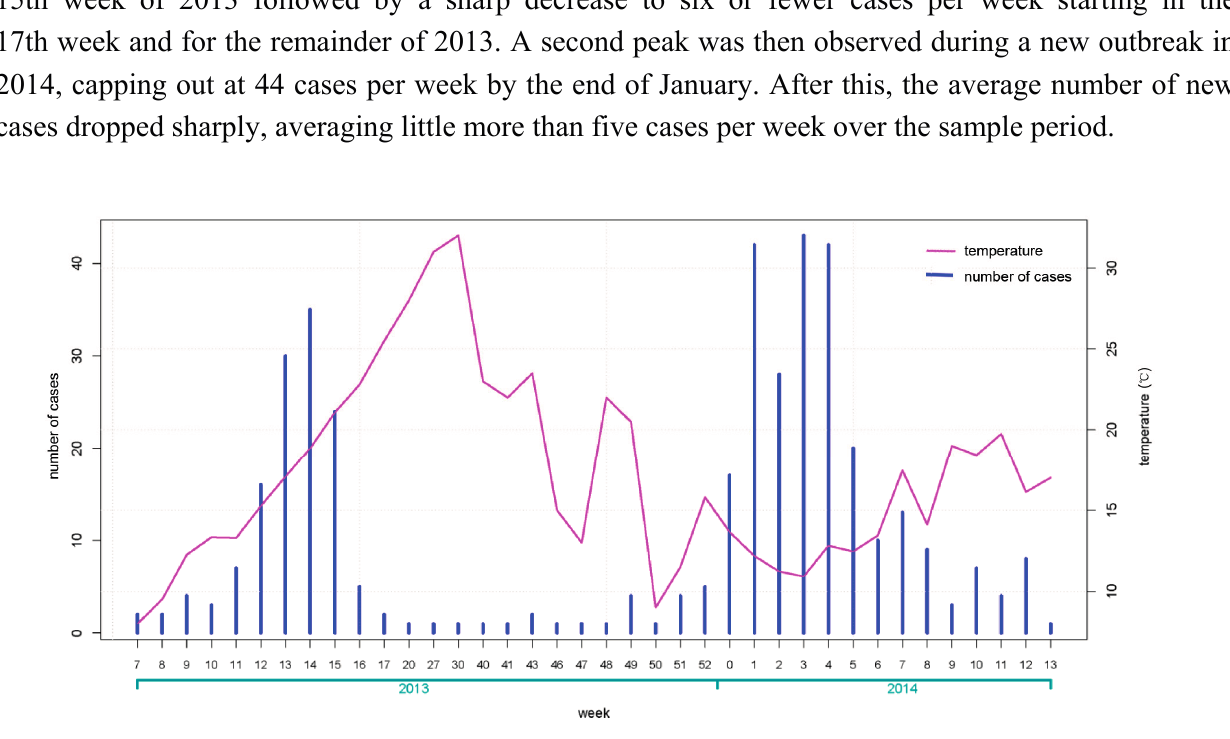
Figure 1. Weekly case number of human infection with avian influenza A (H7N9) virus and average weekly